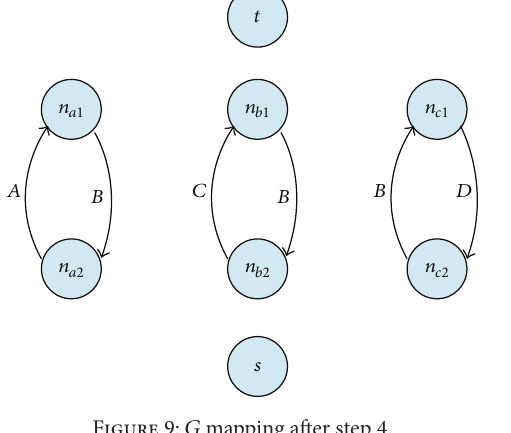
Figure 9: 𝐺 mapping after step 4.